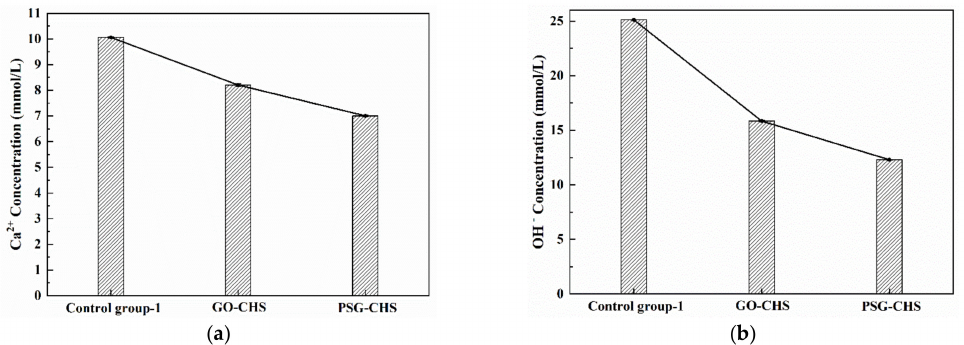
Figure 14. Ion concentrations of Ca(OH) 2 solutions: ( a ) Ca 2+ concentration; and ( b ) OH −